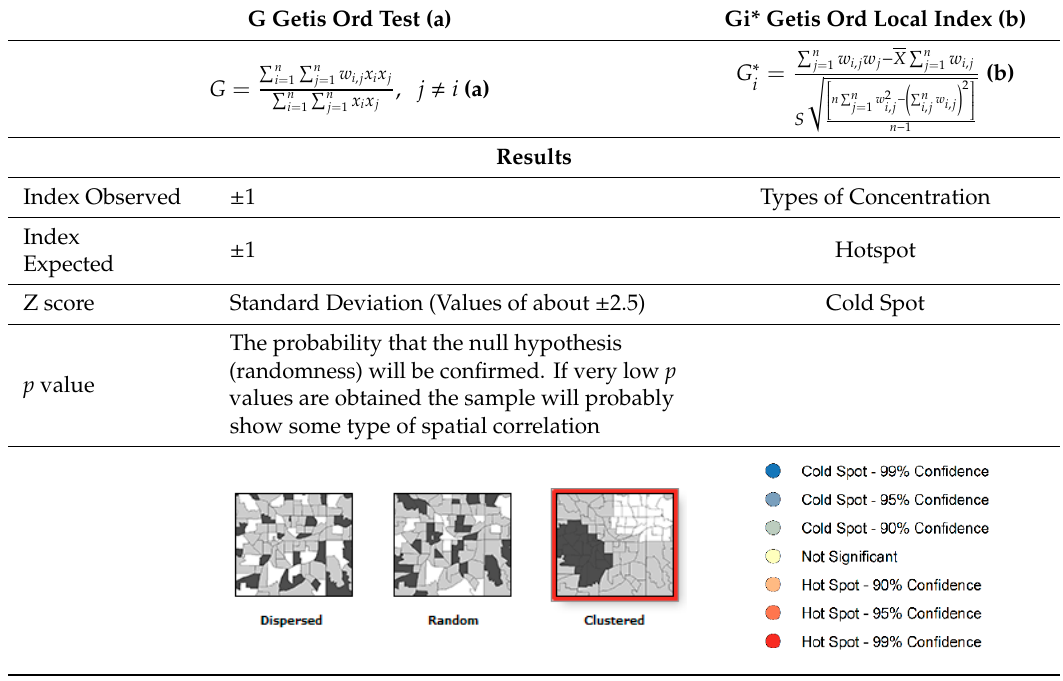
Table 3. Spatial autocorrelation indicators. Figure 3. Methods.